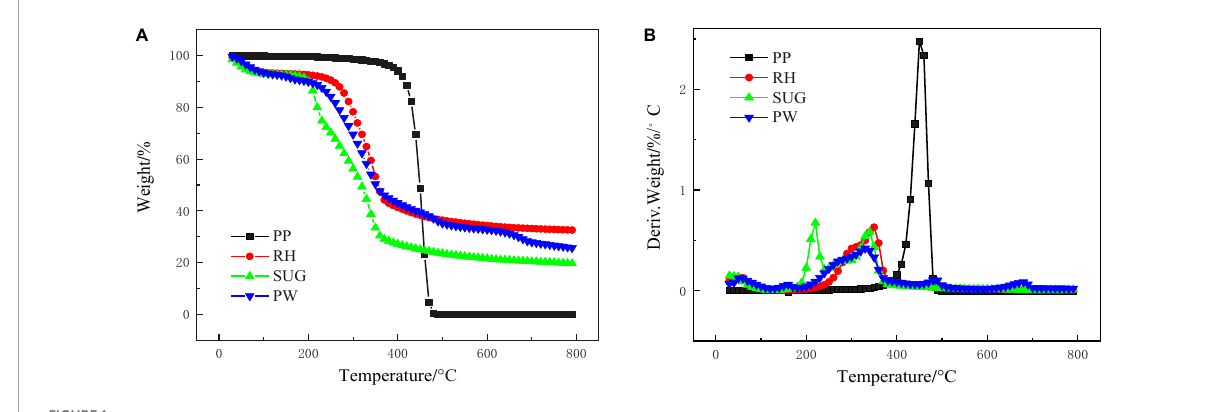
FIGURE1 Pyrolysis characteristics of PP, RH, SUG, and PW with a heating rate of 10 ◦ C/min, (A) TG profiles and (B) DTG